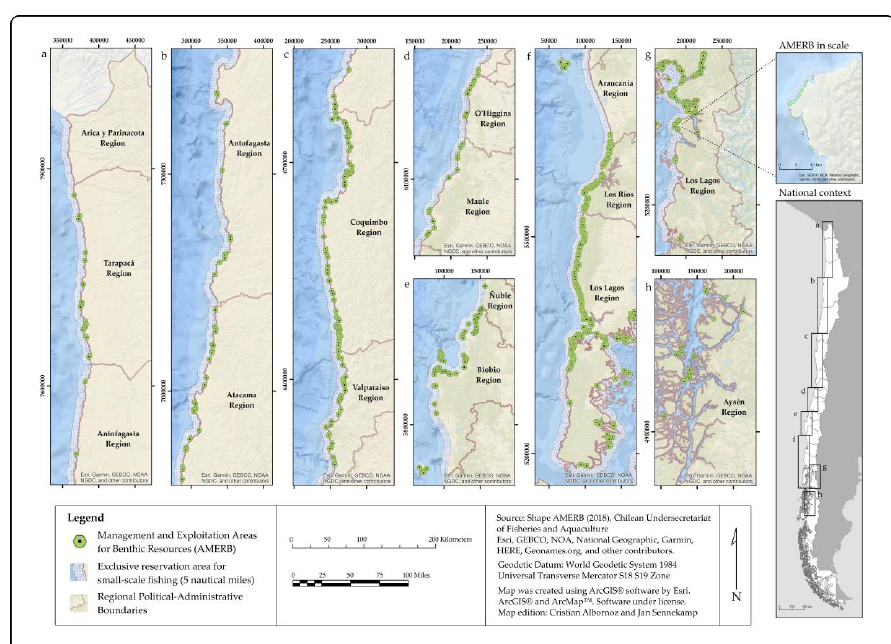
Figure 2. AMERBs in activity according to the regional division of Chile. Environments 2020 , 7 , x